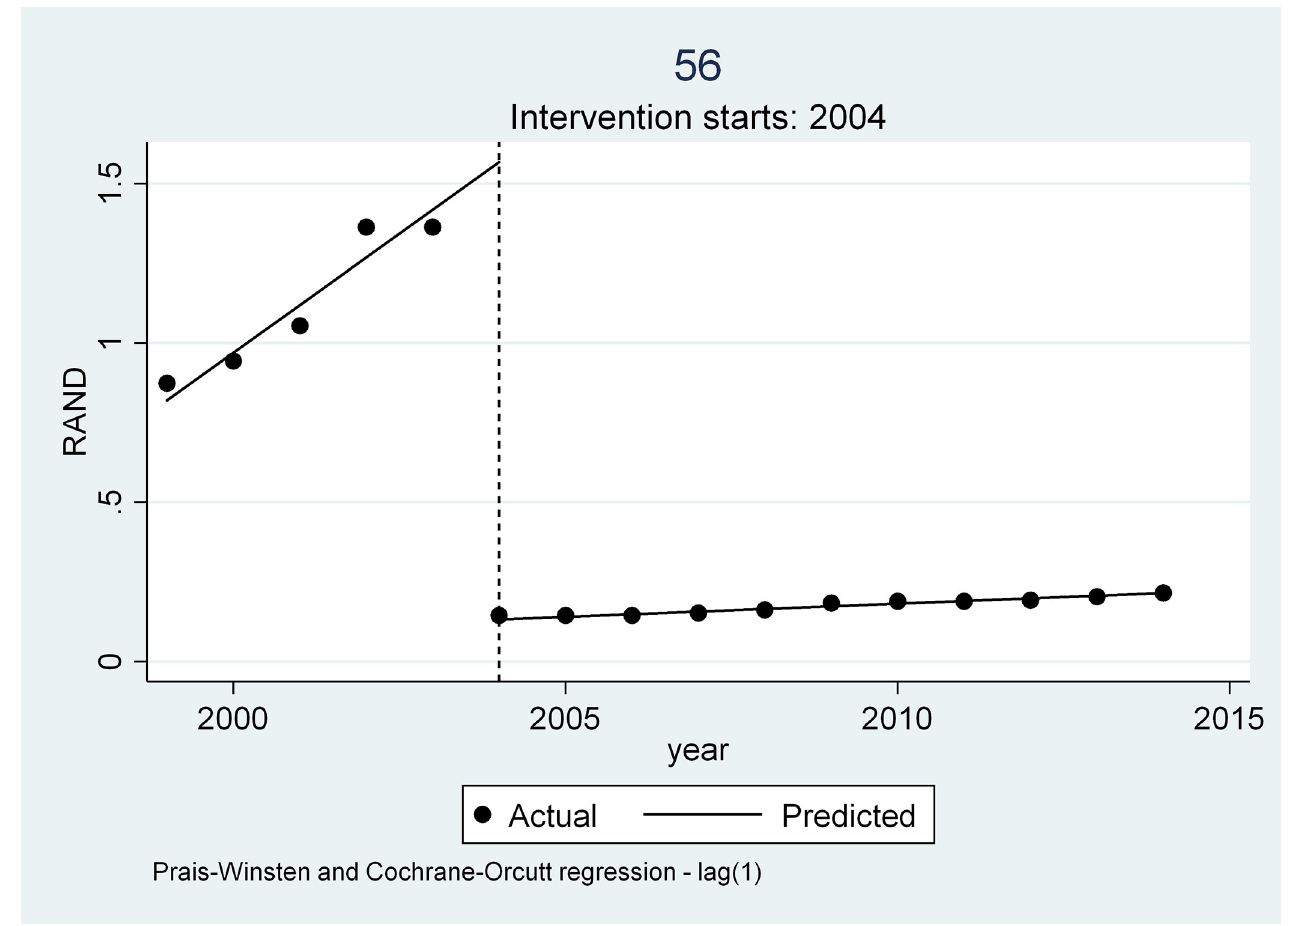
Fig 4. Trend 1 as depicted by Sandoz